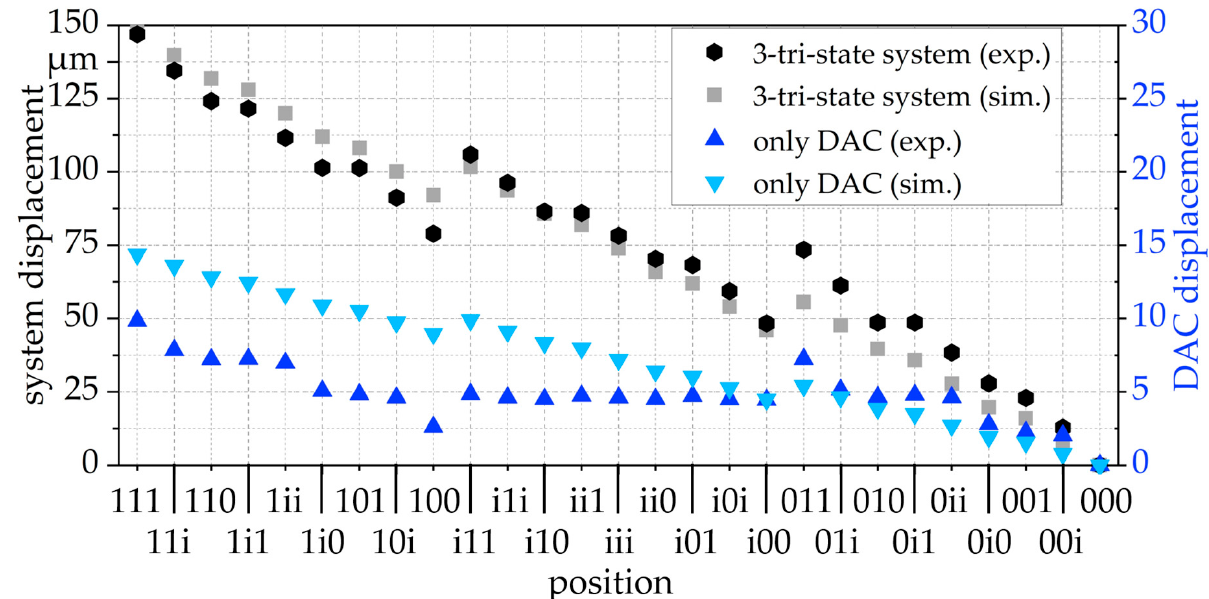
Figure 15. Experimental and simulative displacement of the DAC and the system when activating the microsystem as a 3-tri-state system at the 75-V control voltage. The positions are approached in logical order from the 111 to 000 position including the intermediate i-position (Figure 14c).